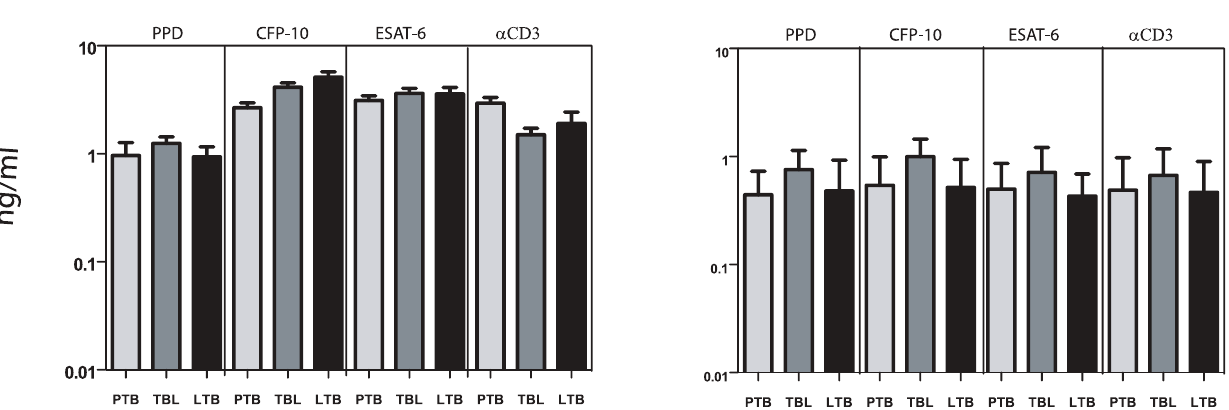
Figure 5. PTB is not associated with antigen – induced alterations in immunoregulatory cytokines. Whole blood from PTB, TBL and LTB individuals was stimulated with (A) PPD (10 m g/ml) or (B) ESAT-6 (10 m g/ml) or (C) CFP-10 (10 m g/ml) or (D) anti-CD3 (5 m g/ml) for 72 h, and levels of immunoregulatory cytokines IL-10 and TGF b were measured by ELISA. Results are shown as net cytokine production over media control. The bars represent geometric means and 95% confidence intervals. P values were calculated using the Kruskal-Wallis test with Dunn’s multiple comparisons